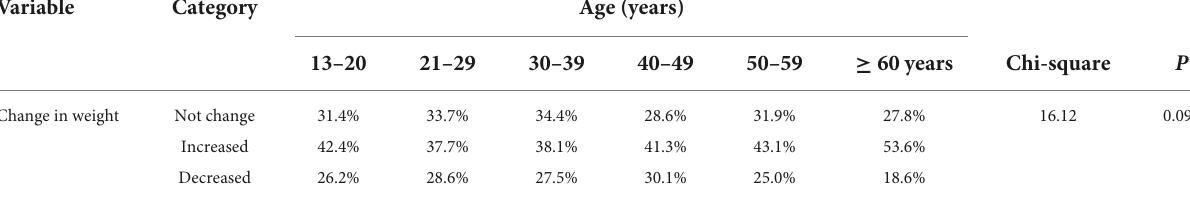
TABLE 6 B.M.I. for age groups before and during the Confinement Period. Variable